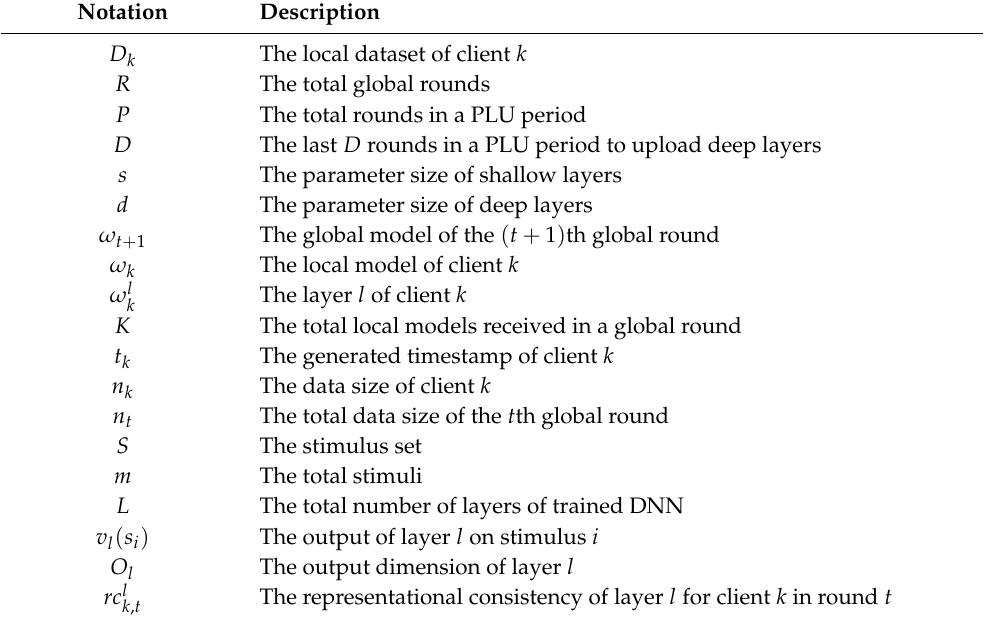
Table 2. The notations used in